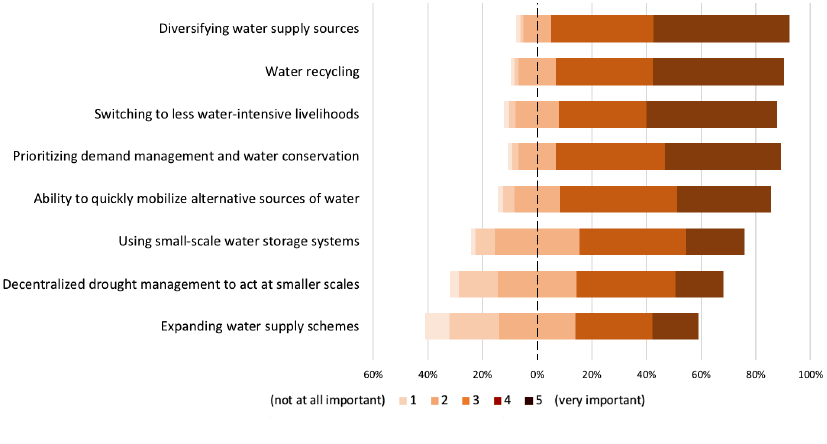
Fig. 3 . Strategies that build resilience to drought. Survey respondents were asked to rate, on a scale of 1 to 5, each of the strategies in terms of how important they are for achieving resilience to drought. While the strategies were randomly ordered on the survey, they are shown here from the highest rated at the top to the lowest rated at the bottom.